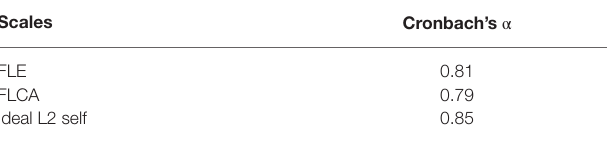
TABLE 2 | Reliability of the scales. Scales